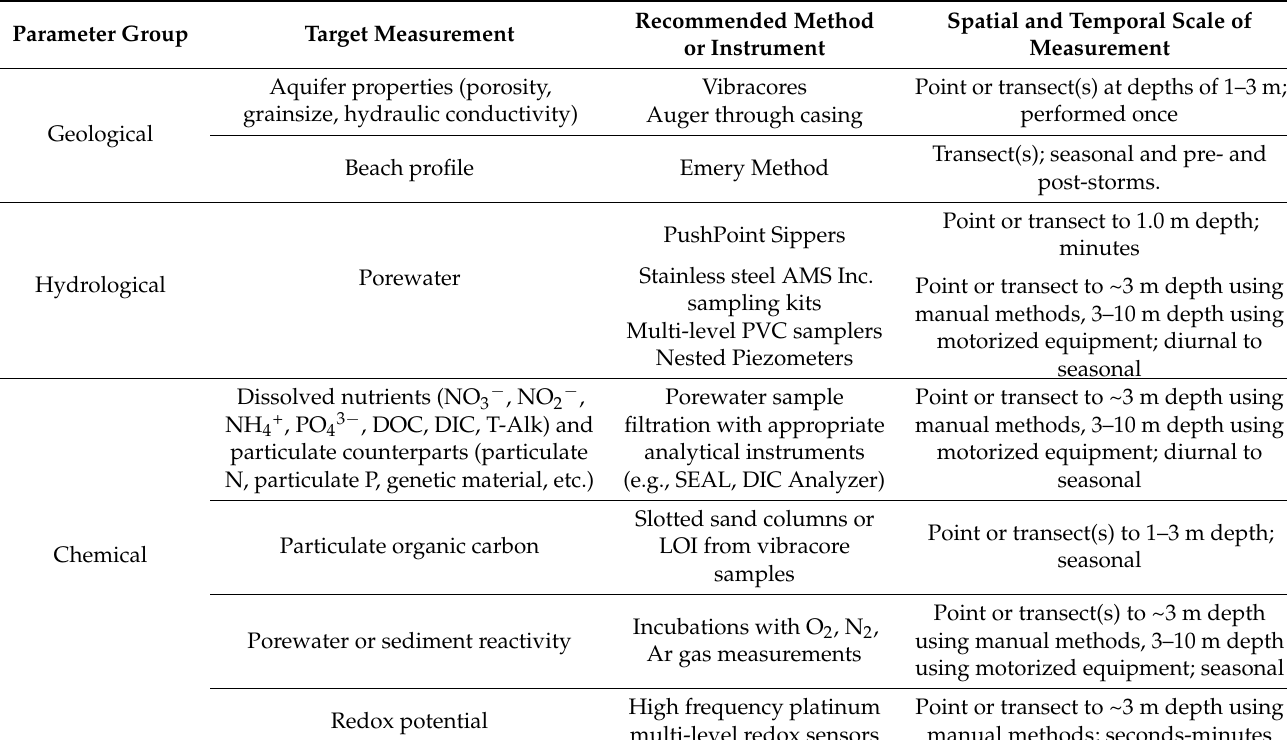
Table 1. Summary of the measurement techniques categorized by parameter group, target measurement, recommended method or instrument, and spatial and temporal scale of